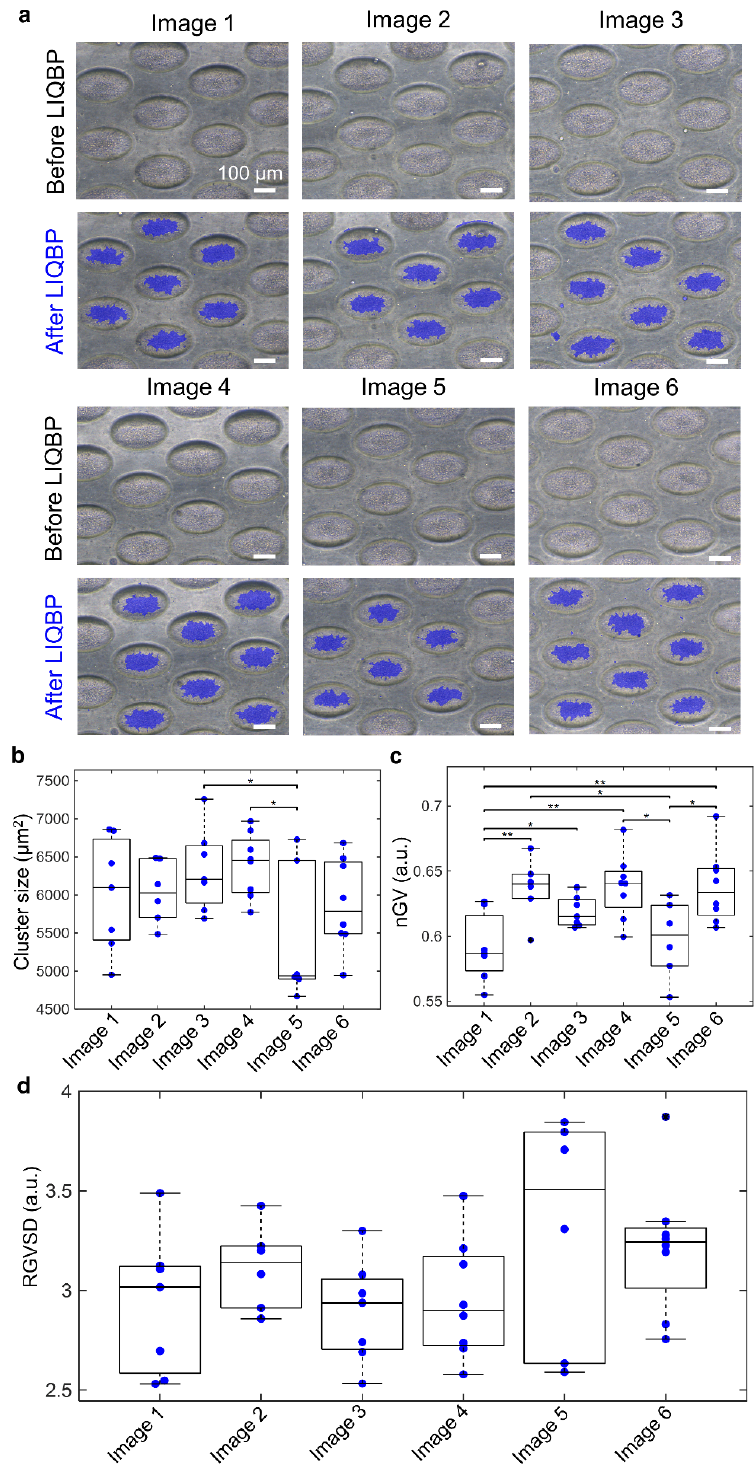
Figure 3. Robustness validation of LIQBP. ( a ) Representative images before the LIQBP and their corresponding detected images after the LIQBP. These images are cell clusters cultured from one patient sample. Blue shades in the detected images represented the detected patient-derived cell cluster. Scale bar, 100 μ m. ( b ) Boxplot of the size of patient-derived cell clusters. ( c ) Boxplot of nGV of patient-derived cell clusters. ** Represents p ≤ 0.01 and * represents p ≤ 0.05. ( d ) Boxplot of RGVS of patient-derived cell clusters. RGVS values across clusters of the same patient remained relatively